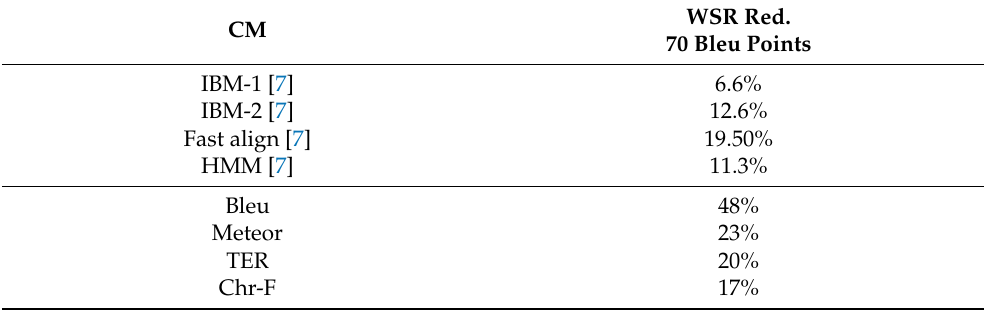
Table 2. WSR reduction obtained from CMs with a translation quality of 70 Bleu points.